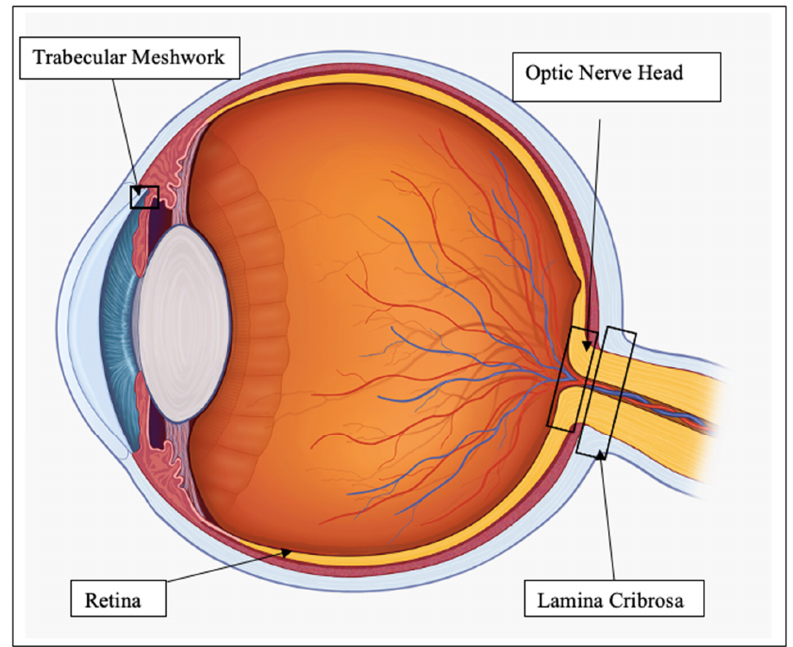
Figure 1. Diagram of eye regions of interest.